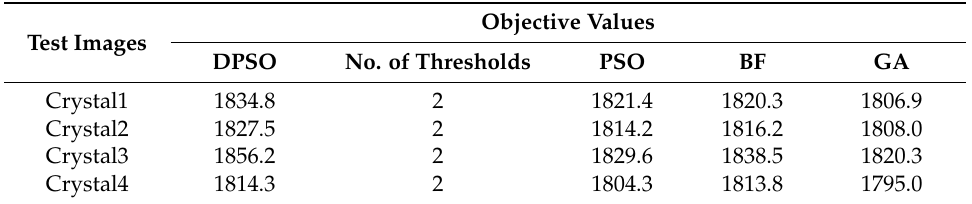
Table 5. Comparative analysis of objective function values obtained by the Otsu-based DPSO method with other bio-inspired multilevel thresholding methods.